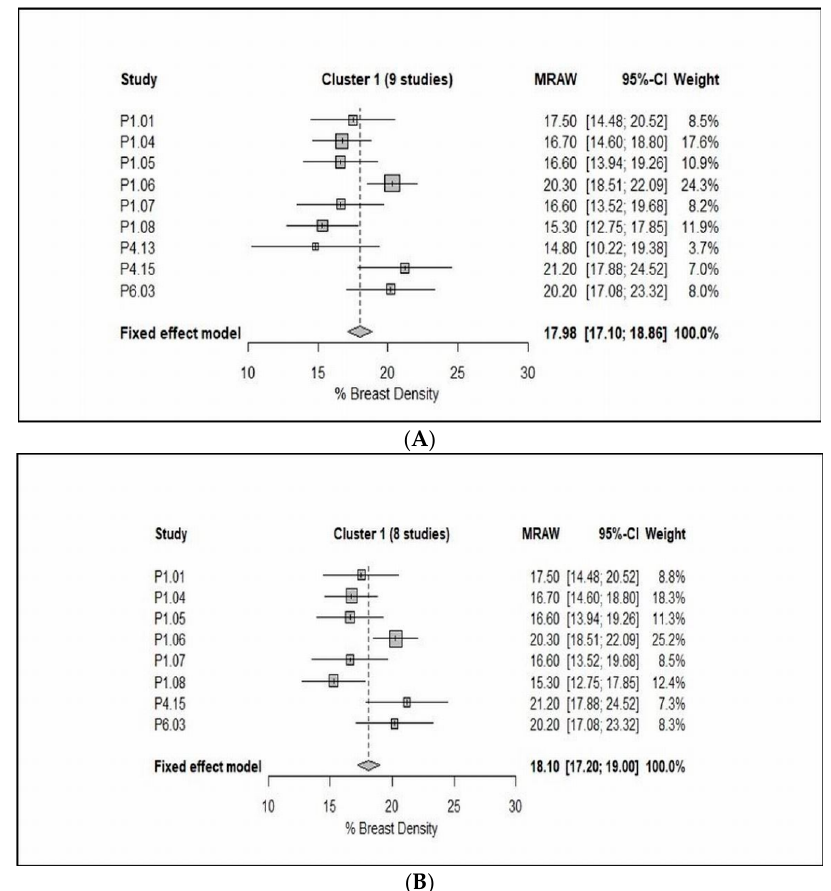
Figure 6. Forest plot of the study means, and 95% confidence limits of the studies in Cluster 1 with/without P4.13 (Choi, 2017) of % breast density. ( A ) Fixed effect meta-analysis of the studies in Cluster 1 (9 studies) of % breast density. ( B ) Fixed effect meta-analysis of the studies in Cluster 1 (8 studies) of % breast density.